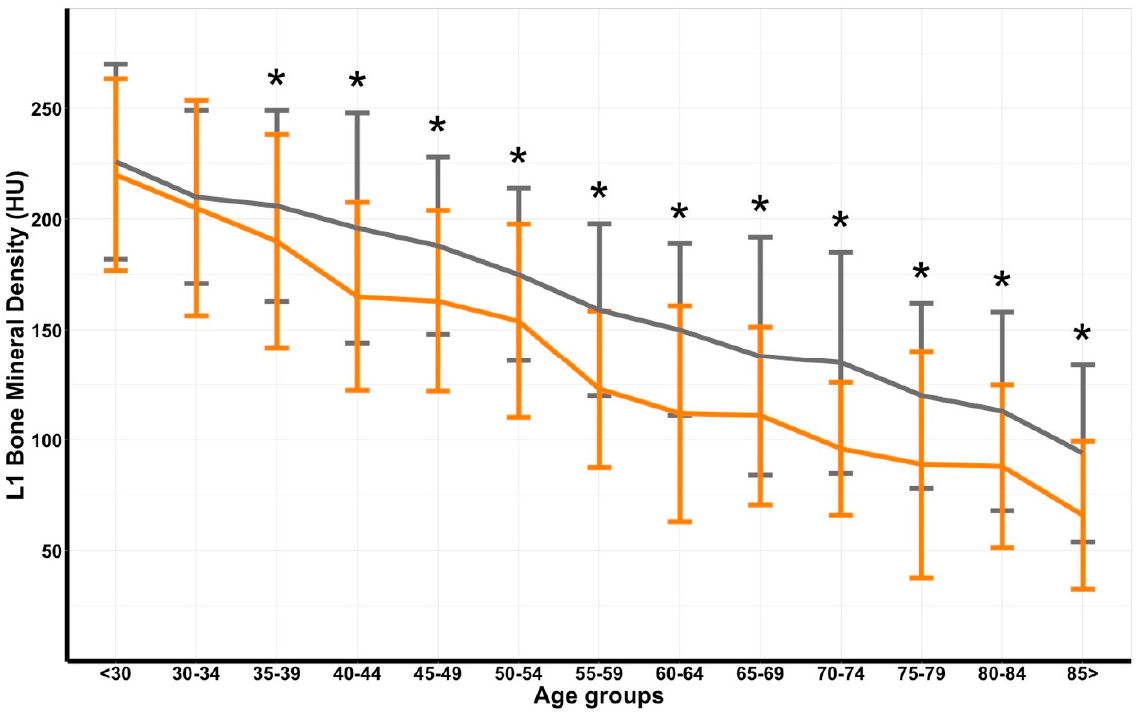
Figure 3. Errorbar plot of bone mineral density (in Hounsfield Units [HU]), displayed in mean and standard deviation, with comparison line graphs of means per 5 ‐ year interval showing the Dutch trauma cohort (orange) versus the North American reference cohort (gray) [13]. The asterisk indicates statistical significance.